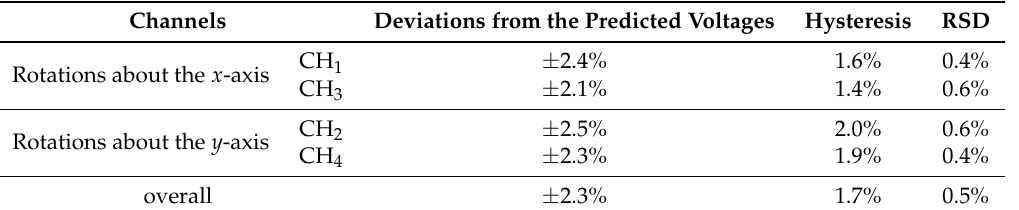
Table 1. Output characteristics of the optical